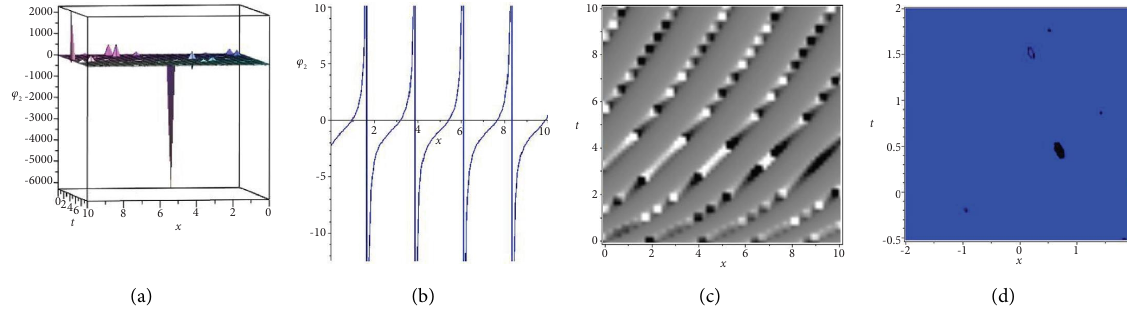
� 3 , a � 0 , λ � 2 ,b � 0 ,and b � ( 3/2 ) (a) 3D surface (b) 2D surface (c) Density 0 1 1 2